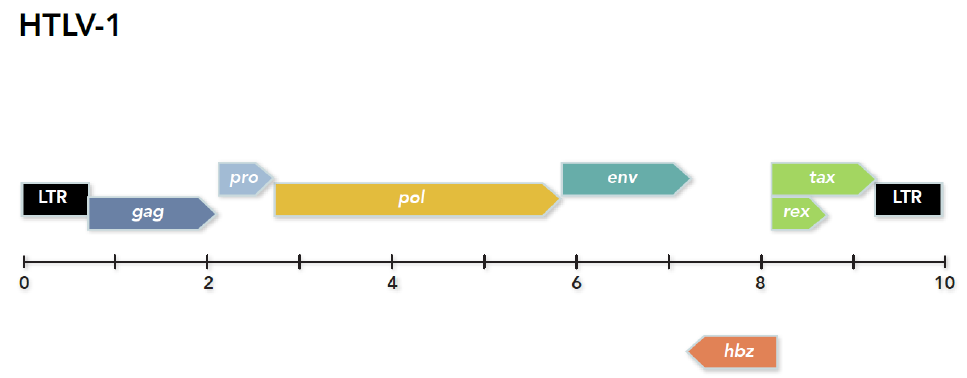
Figure 3. Organization of the HTLV-1 genome.